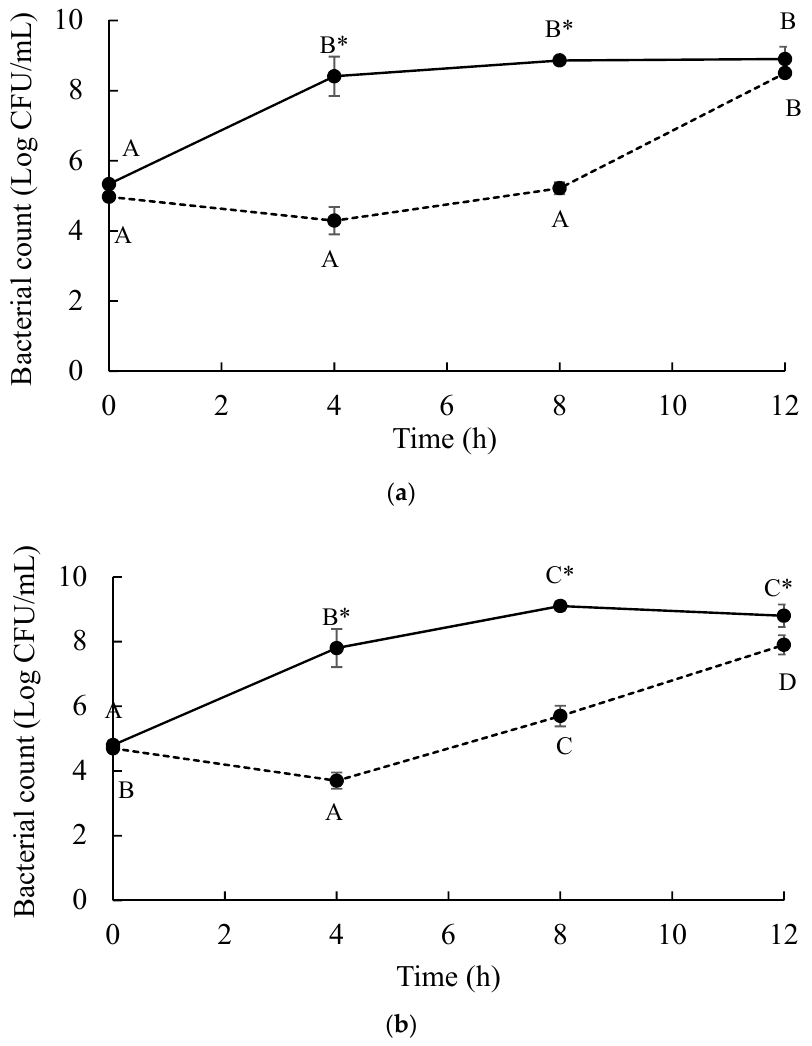
Figure 3. Survival of ( a ) S. Enteritidis and ( b ) S. Typhimurium treated with a phage cocktail at 37 °C for 12 h. Control (non-phage cocktail treated) presented by and treatment of a phage cocktail presented by . Bars represent the mean standard deviation ( n = 3). The sign (*) on the lines indicates significant differences ( p < 0.05) of bacterial count between control and treatment during storage time for a given Salmonella strain. Different uppercase letters on the lines indicate significant differences ( p < 0.05) of bacterial count among days of storage for a given Salmonella strain.